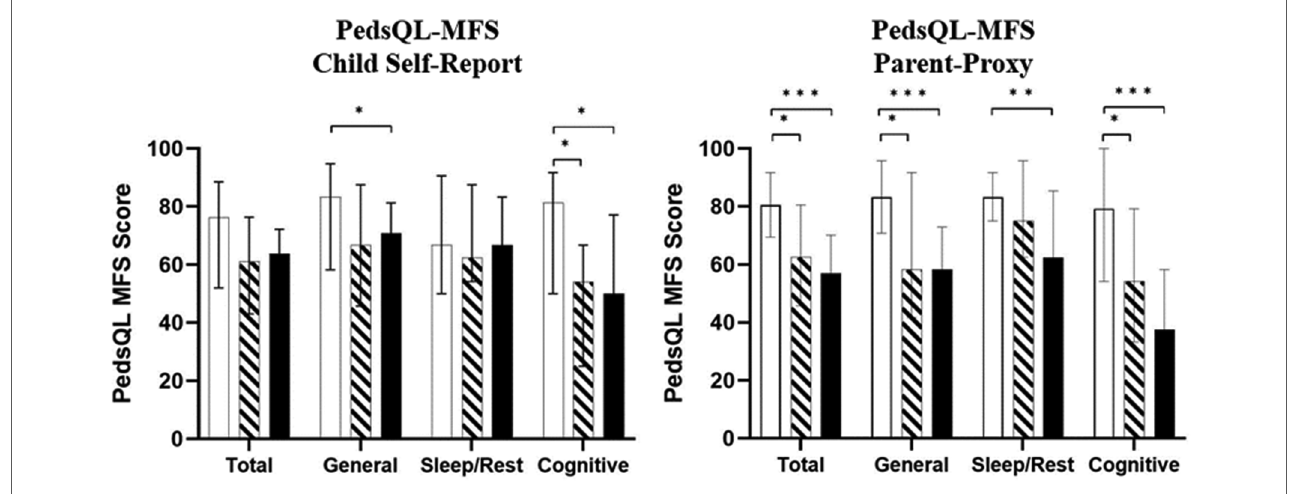
FIGURE 2 Median pediatric quality of life inventory multidimensional fatigue scale (pedsQL-MFS) scores for child self-report (left) and parent-proxy (right) respondents. Error bars shown represent medians±IQRs. Lower values indicate greater fatigue. CNH; white bars, CUHL; oblique stripes, CBHL; black bars respectively. Asterisks show signi fi cant differences between groups (* p <0.05, ** p <0.01, *** p <0.001).